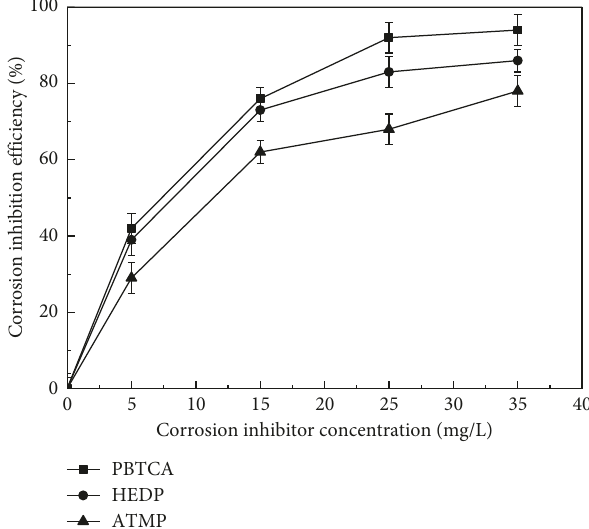
Figure 2: Effect of concentration of the three corrosion inhibitors on the inhibition of corrosion of carbon